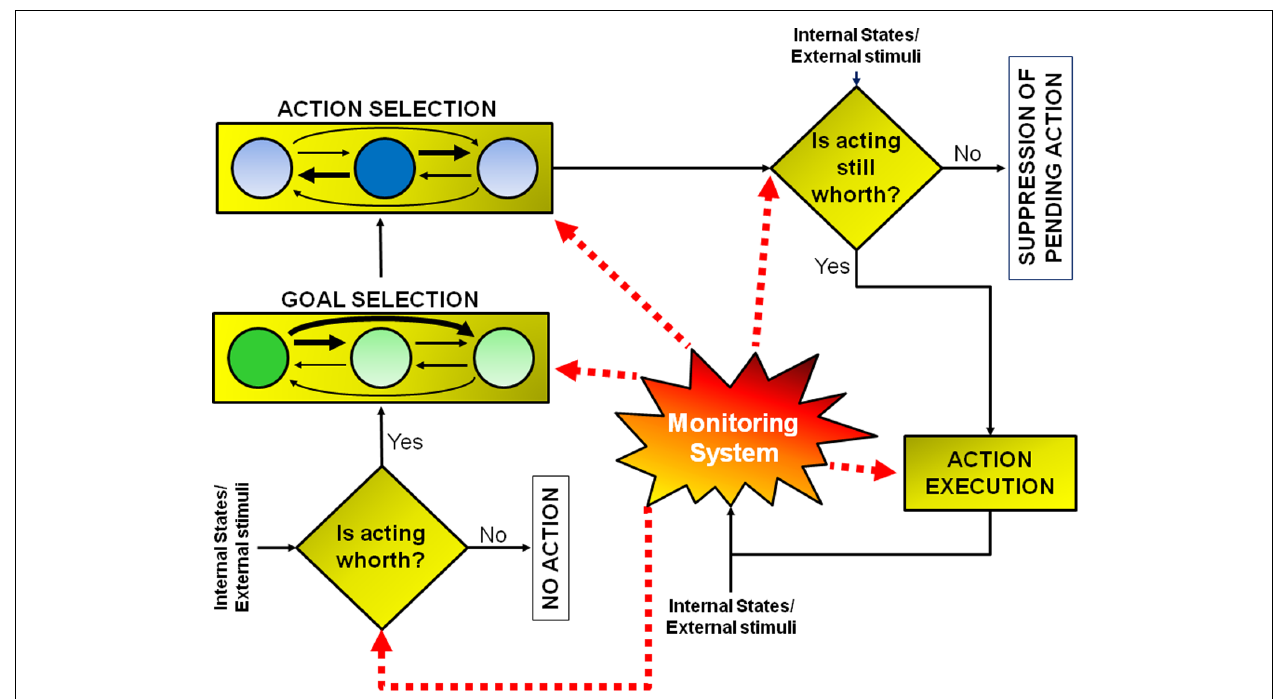
decision aimed at evaluating whether acting is worthwhile must occur before goal or action selection), but other processes occur in parallel (e.g., the monitoring system, whose role is to compute predictions about future reward and to measure discrepancies between expected and actual outcomes, is active during all the steps). See text for further